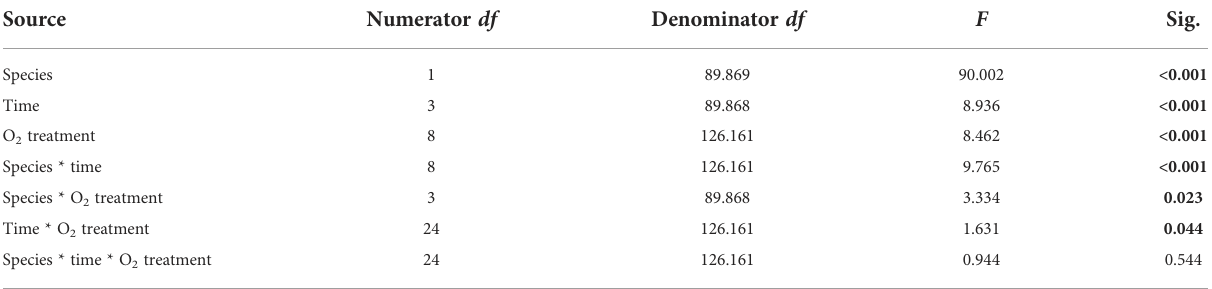
TABLE 3 Summary of results for LMMs comparing effective F ′ / F m ′ reading between treatments throughout the experiment.